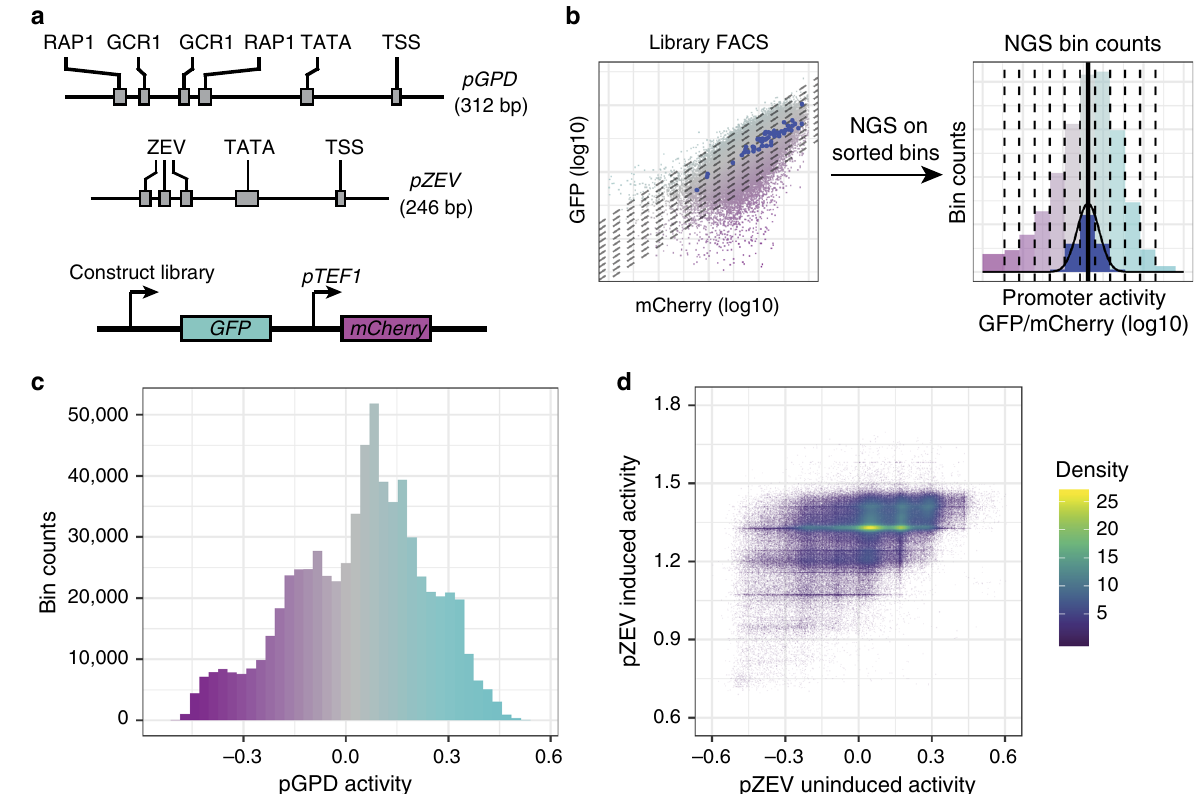
Fig. 1 FACS-seq experimental strategy and data set overview. a Schematic of tested libraries (above), indicating regions held constant in promoter design (gray boxes); schematic of two-color reporter device used to characterize promoter activity (below). RAP1, GCR1, ZEV transcription factor binding sites, TATA TATA box motif, TSS transcription start site motif. b Schematic of FACS-seq approach for high-throughput promoter activity characterization, in which next-generation sequencing (NGS)-derived histograms of sequence counts in FACS bins generated by sorting a library on promoter activity are used to derive promoter activity (log10 ratio of GFP to mCherry intensity, in arbitrary units) for each sequence in a library. Solid line: point estimate of promoter activity for an example sequence (blue points and histogram bins). Color gradient qualitatively indicates GFP:mCherry ratio for each cell or bin. c Histogram of promoter activities (log10 ratio of GFP to mCherry intensity, in arbitrary units) in the fi nal P GPD library. Only sequences for which at least ten NextSeq reads were counted in each replicate were used in this analysis. Color gradient qualitatively indicates GFP:mCherry ratio for each sequence. d Density scatter plot of induced and uninduced promoter activities measured in the fi nal P ZEV library. Only sequences for which at least 20 NextSeq reads were counted in each replicate were used in this analysis. Density: density of plotted points (arbitrary